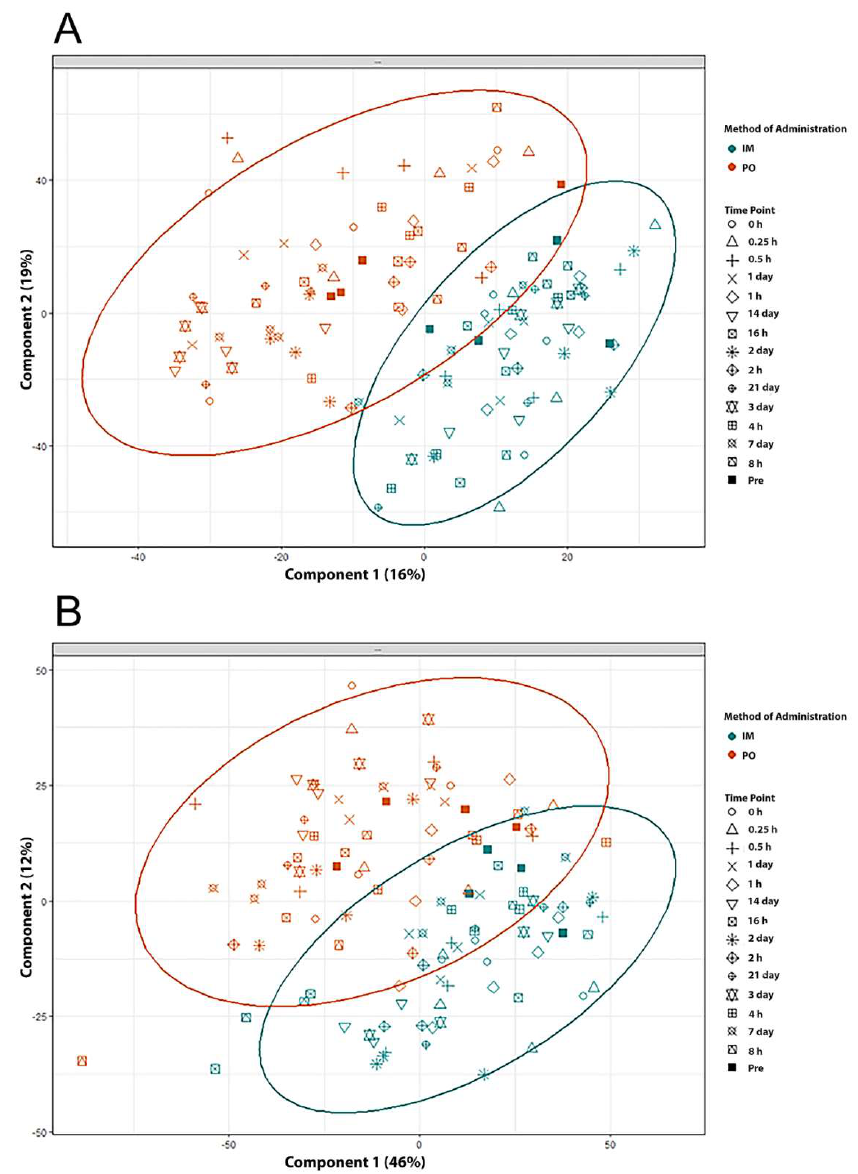
Figure 2. PLS-DA analysis to determine longitudinal changes in metabolomic profiles after BIO 300 administration by either the im or po routes, in ESI positive (panel A ) and ESI negative (panel B ) mode.